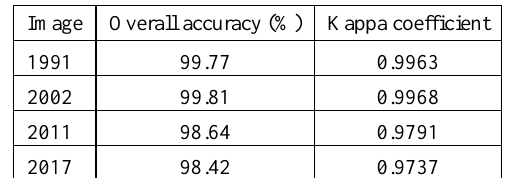
Table 3. The classification accuracy of each Landsat image.